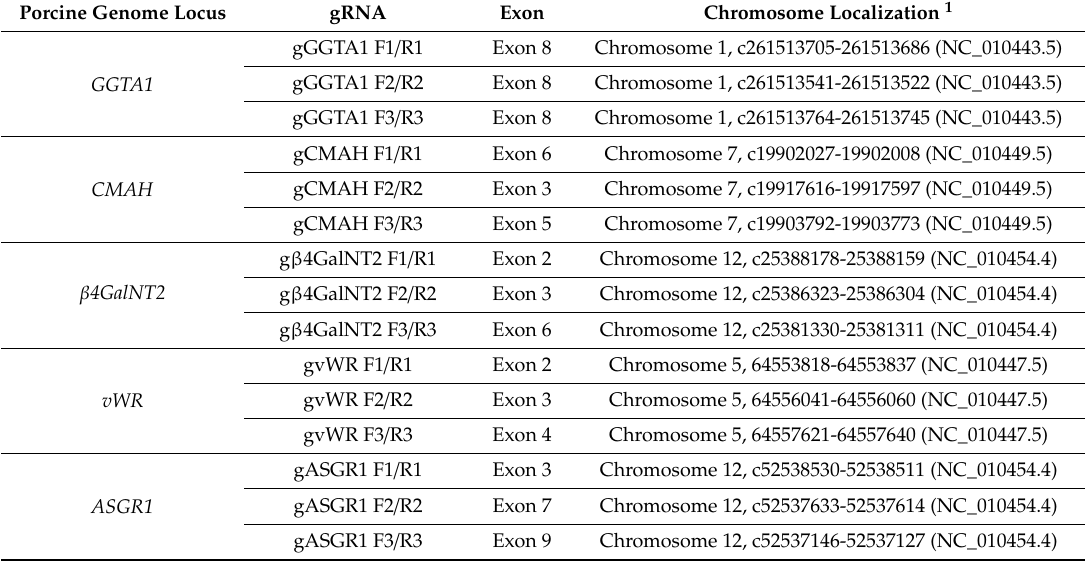
Table 1. Localization of the potential modification loci in porcine